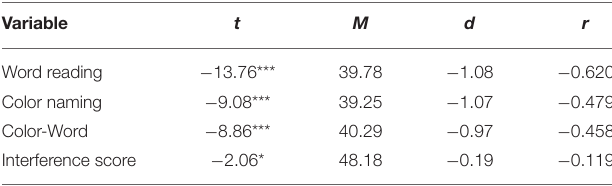
TABLE 6 | One-sample t -test for the mean comparison between CPOs and the cut-off score for impairment ( T = 40) as test value in the Stroop tasks. Variable